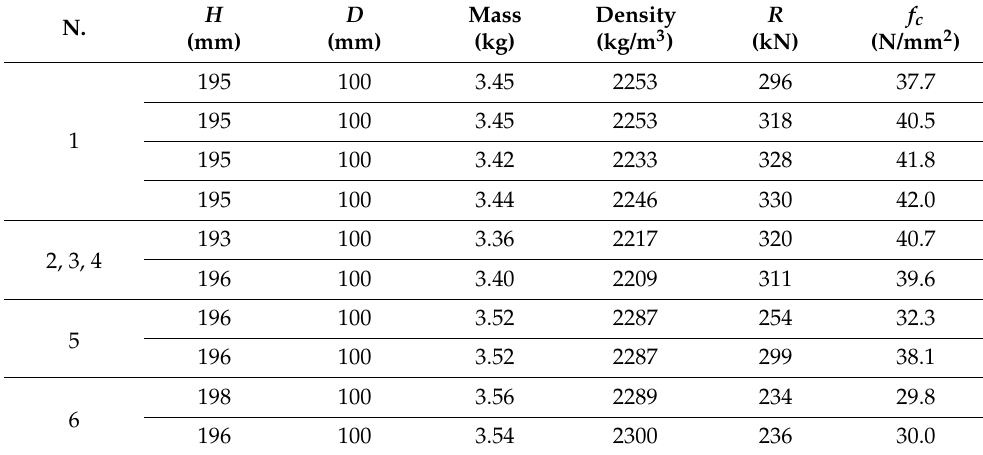
Table 2. Results of compression tests on concrete specimens.